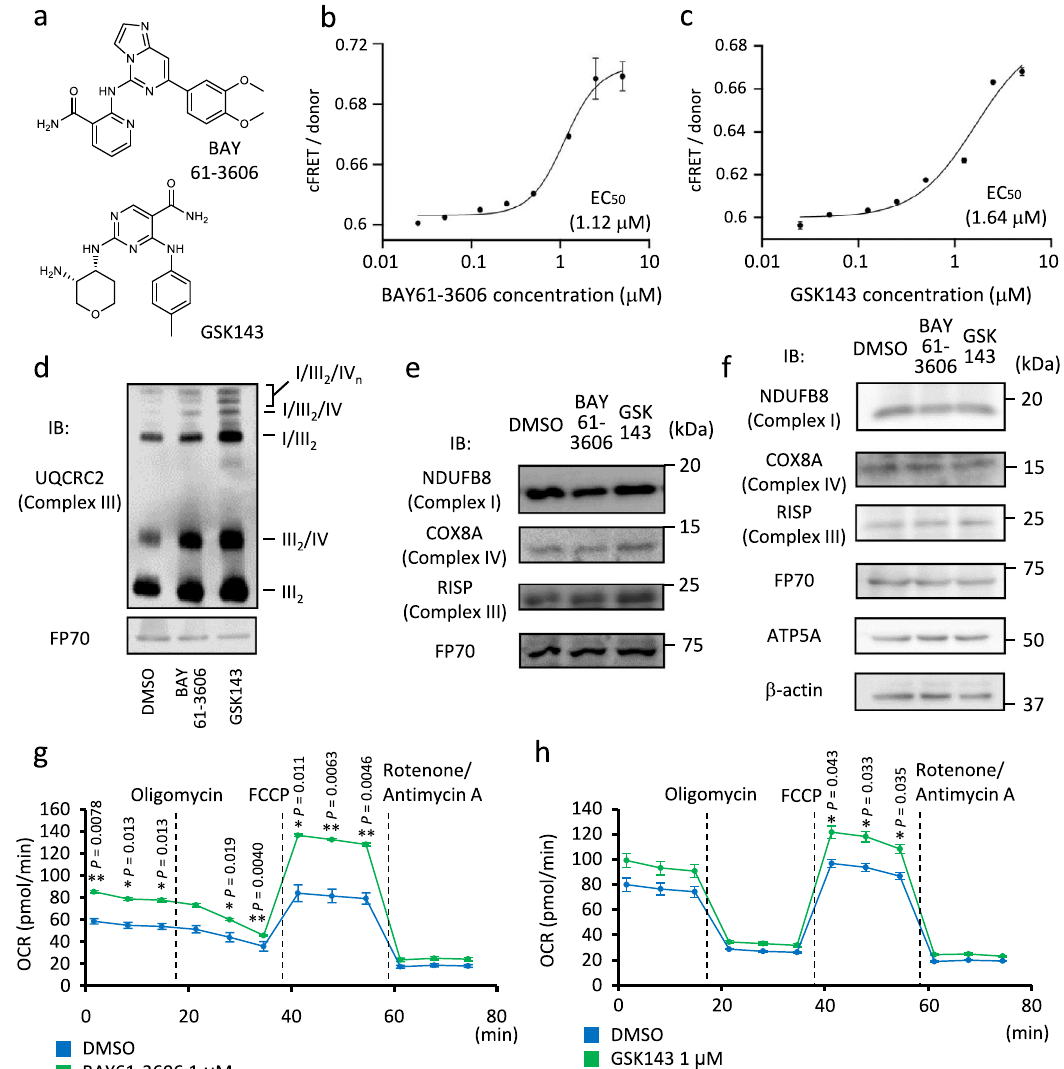
Fig.4|SYKinhibitorspromotemitochondrialrespiratorychainsupercomplex assembly and stimulates oxygen consumption in C2C12 myoblastic cells. a ChemicalstructuresofBAY61-3606andGSK143. b , c cFRET/donorratioofC2C12 cells stably co-expressing NDUFB8-AcGFPand COX8A-DsRed-Monomer treatedby different concentrations of BAY61-3606 ( b ) and GSK143 ( c ). Data are presented as means±SEofthreewellsforeachtreatment. d BN-PAGEofmitochondrialproteins from C2C12 cells treated with indicated SYK inhibitors (1 μ M each) or DMSO for 24h. Positions corresponding to indicated mitochondrial supercomplexes and dimerized complex III (III 2 ) are indicated. Immunoblot (IB) was probed with anti- UQCRC2.FP70wasanalyzedasaninternalcontrol. e IBforamitochondrialfraction